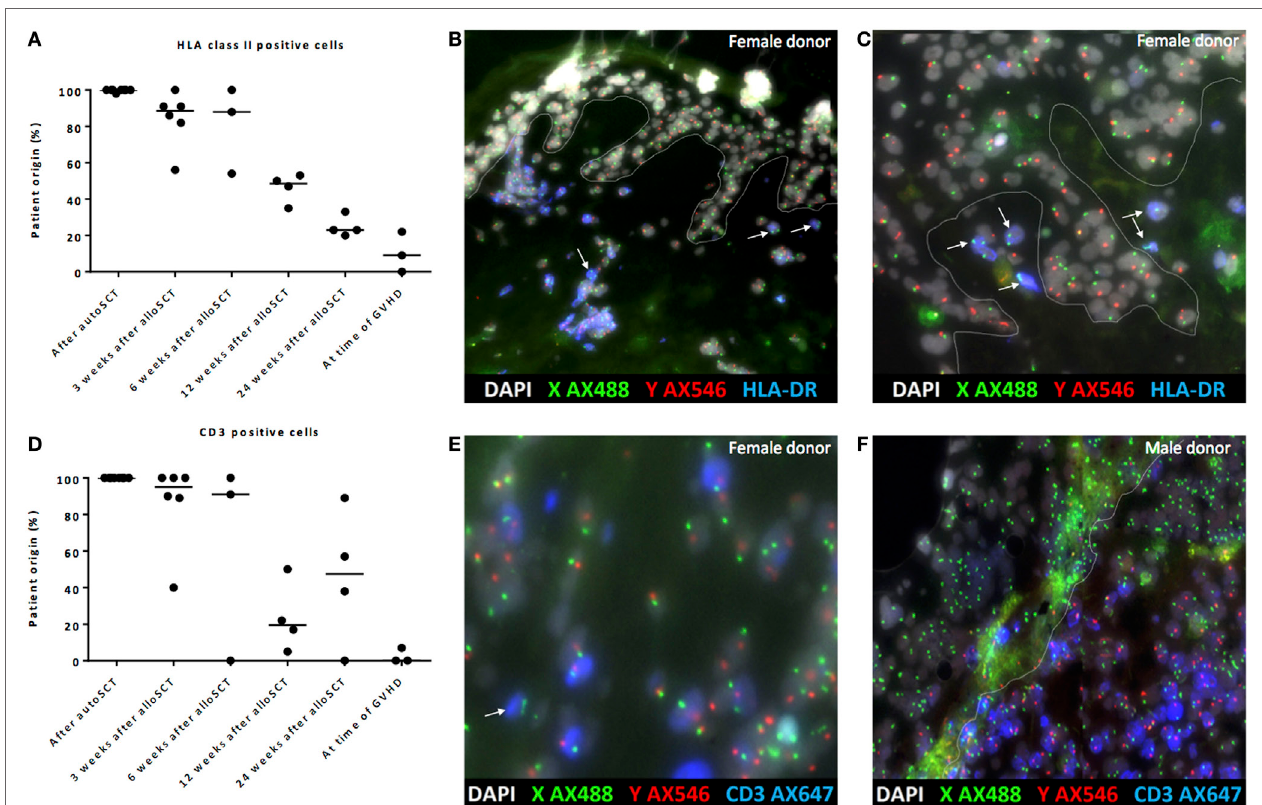
FigUre 5 | Gradual replacement of cells from recipient origin by cells of donor origin. (a) Percentage of recipient origin HLA class II-positive cells in the skin declined over time after allogeneic stem cell transplantation (alloSCT), but remained present even after 24 weeks. After autologous stem cell transplantation (autoSCT), no mixed chimera were observed, and in biopsies taken at the time of graft-versus-host disease (GVHD), the majority of HLA class II-positive cells were from donor origin. (B) Skin biopsy taken 3 weeks after alloSCT from a male patient with a female donor. All epithelial cells were XY, and nearly all HLA class II-positive cells were XY although some HLA class II-positive cells were XX (white arrows). (c) Skin biopsy taken 24 weeks after alloSCT from a male patient with a female donor. All epithelial cells were XY and all HLA class II-positive cells in this part of the biopsy were XX (white arrows). (D) Big differences were observed in the skin biopsies regarding the chimerism of CD3-positive cells. (e) 3 weeks after alloSCT, nearly all CD3-positive cells were from patient origin, except those indicated with a white arrow (male patient with female donor). (F) At the time of GVHD all CD3-positive cells were from donor origin (infiltrate of male donor CD3-positive cells in the skin of a female patient). White line demarks the border between dermis and